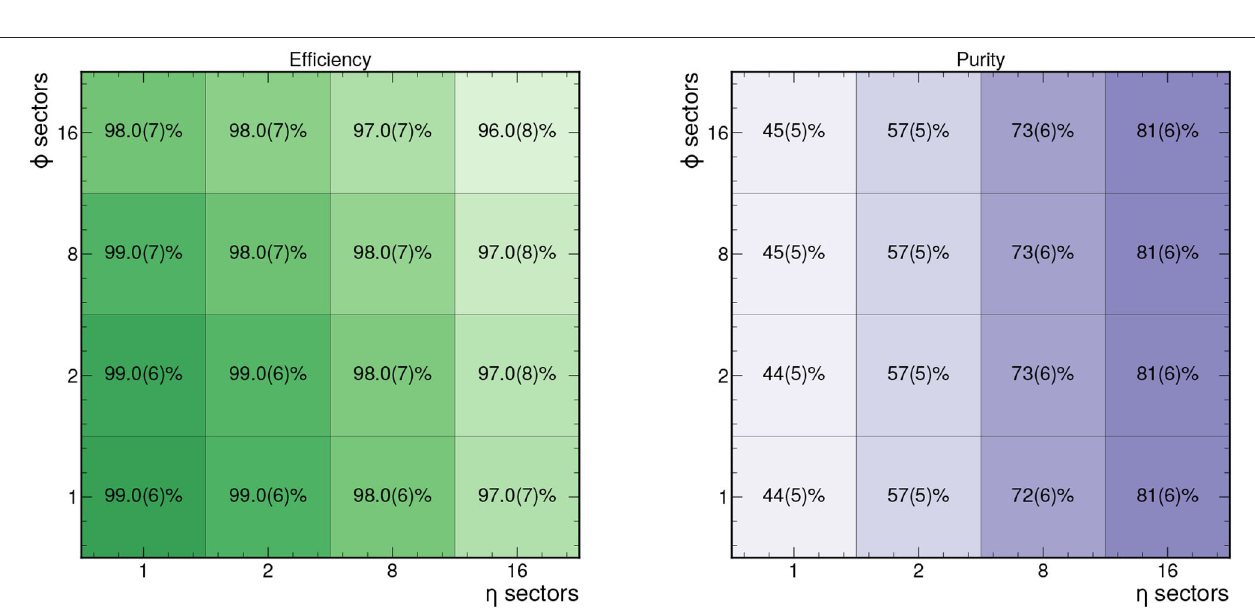
FIGURE 2 | Example graphs showing 2 of the sectors for one event with p min T segments are denoted by blue edges, while false track segments are denoted by gray.